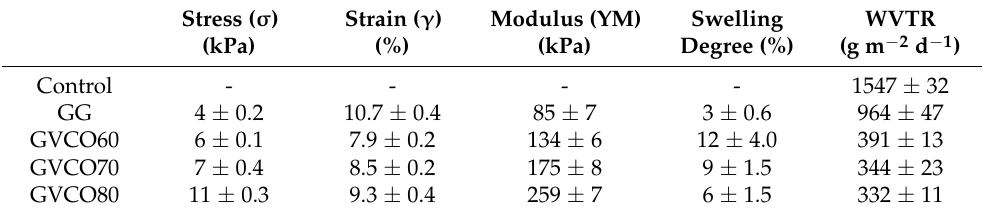
Table 2. Summary of the stress-at-break ( σ ), strain-at-break ( γ ), Young’s modulus (YM), swelling degree, and water vapor transmission rate (WVTR) of gellan gum (GG) and GVCO hydrogels at different ratios. Control for WVTR is a test without hydrogel